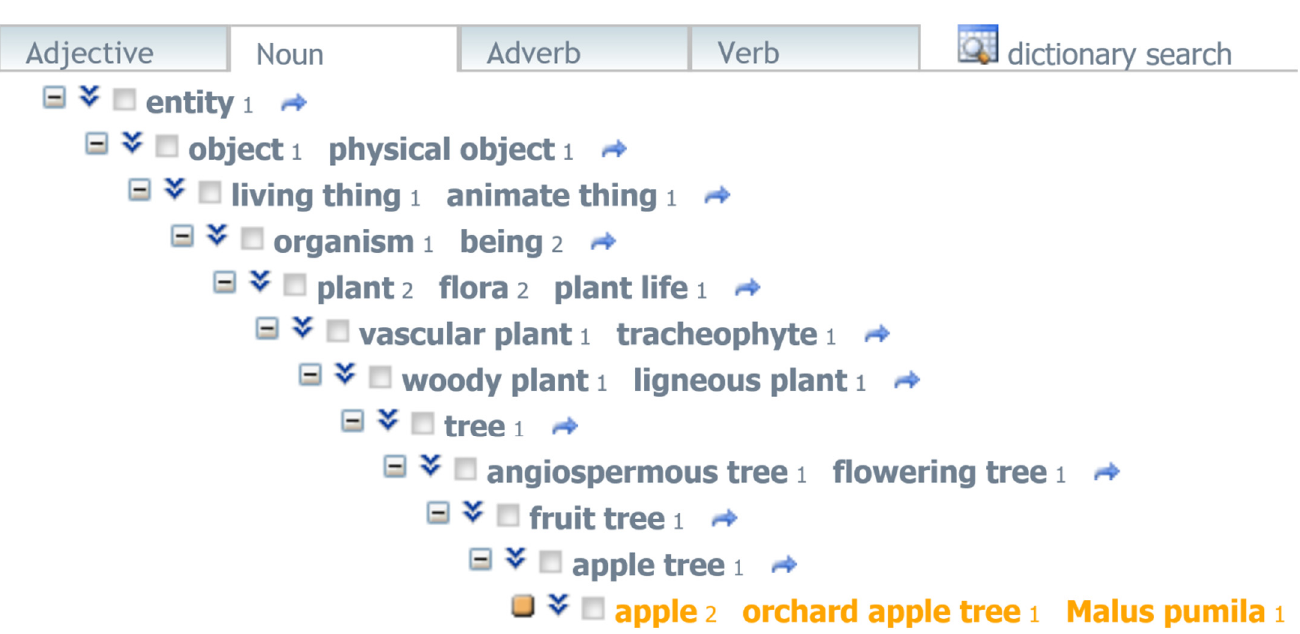
Figure 1. Example of Korean Lexical Semantic Network.